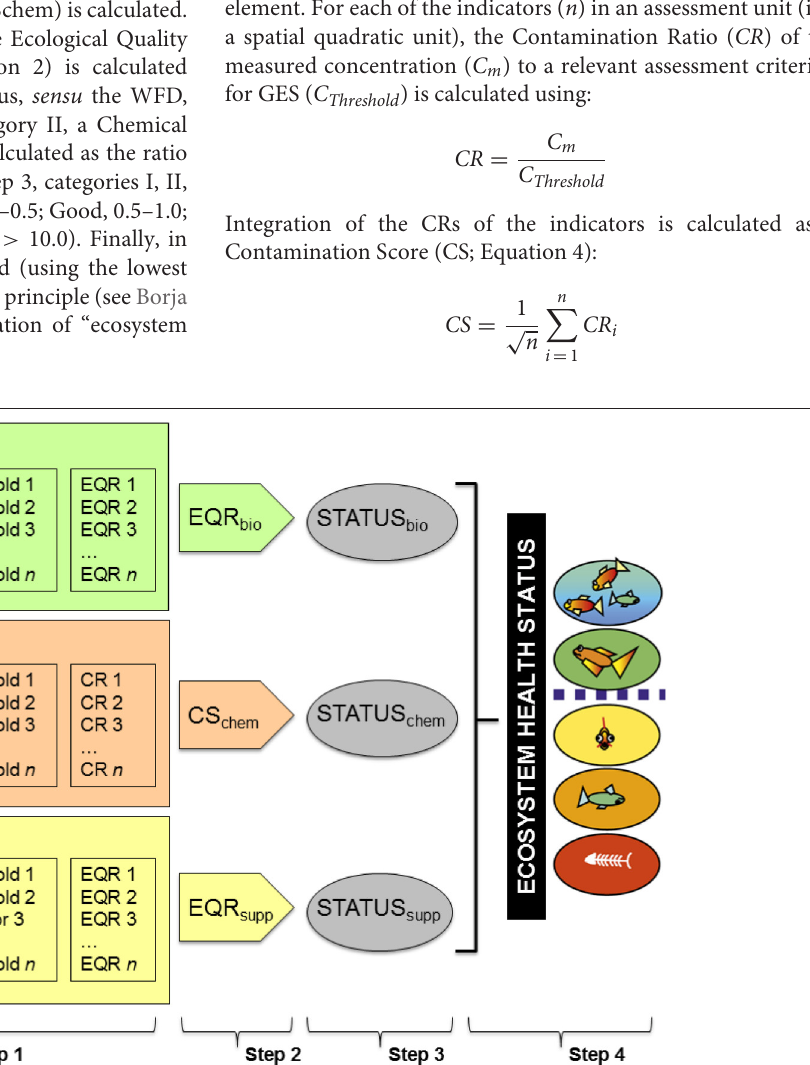
Frontiers in Marine Science |